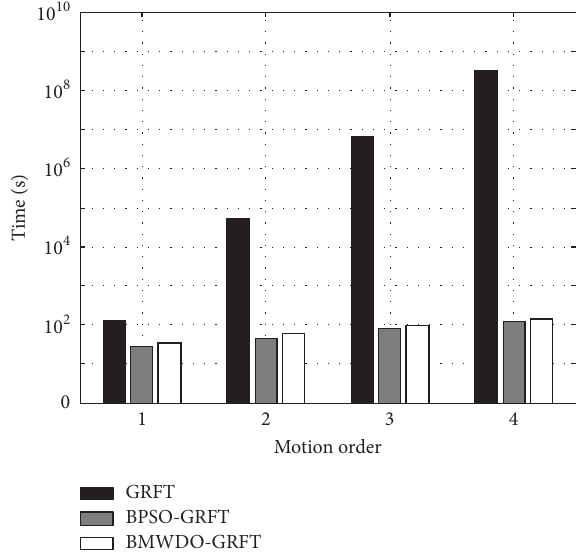
Figure 7: Computational cost of GRFT, BPSO-based GRFT, and the proposed BMWDO-based